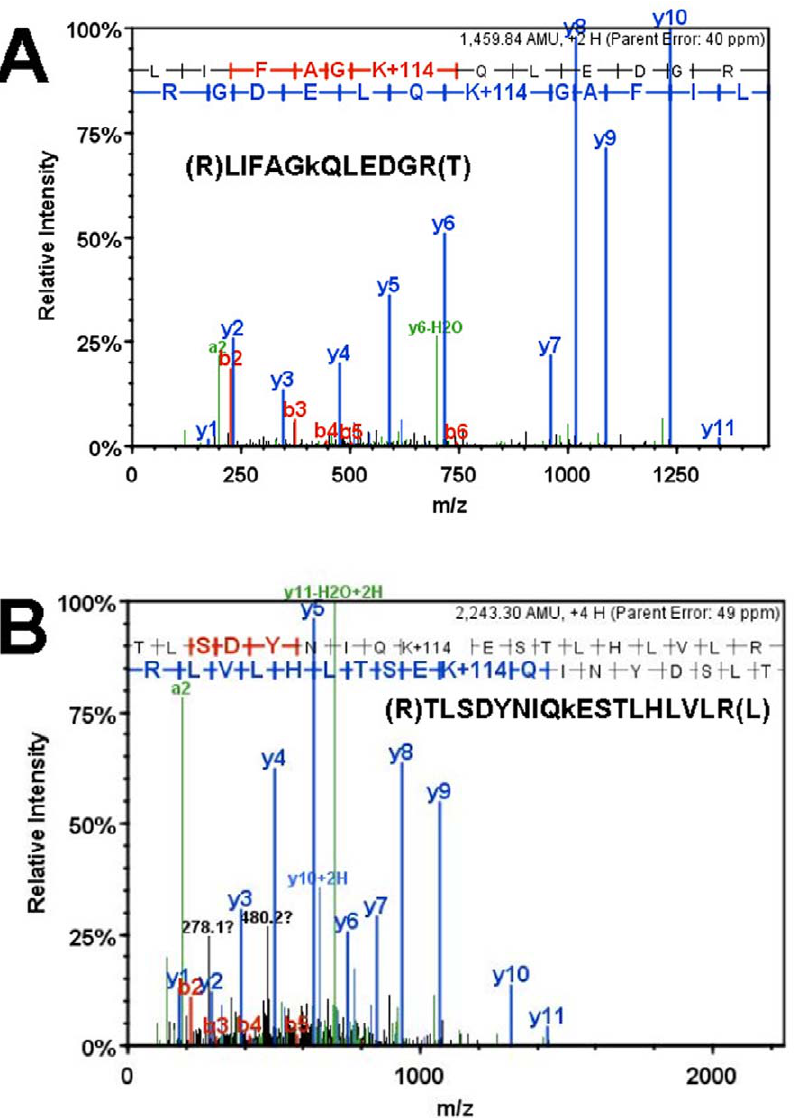
Figure 7. Representative spectrum of polyubiquitin linkage signatures for K-48 ubiquitin conjugation (A) and K-63 ubiquitin conjugation(B). Mass K + 114 is the marker of ubiquitination (K-GlyGly modification). These spectra were abundant in both proteomic analyses.